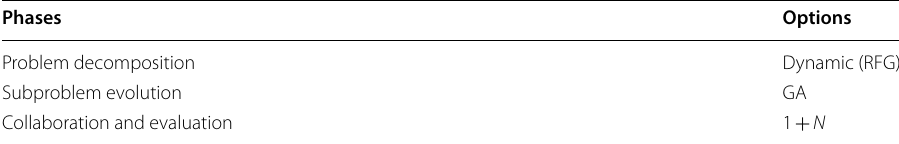
Table 4 The CC parameters